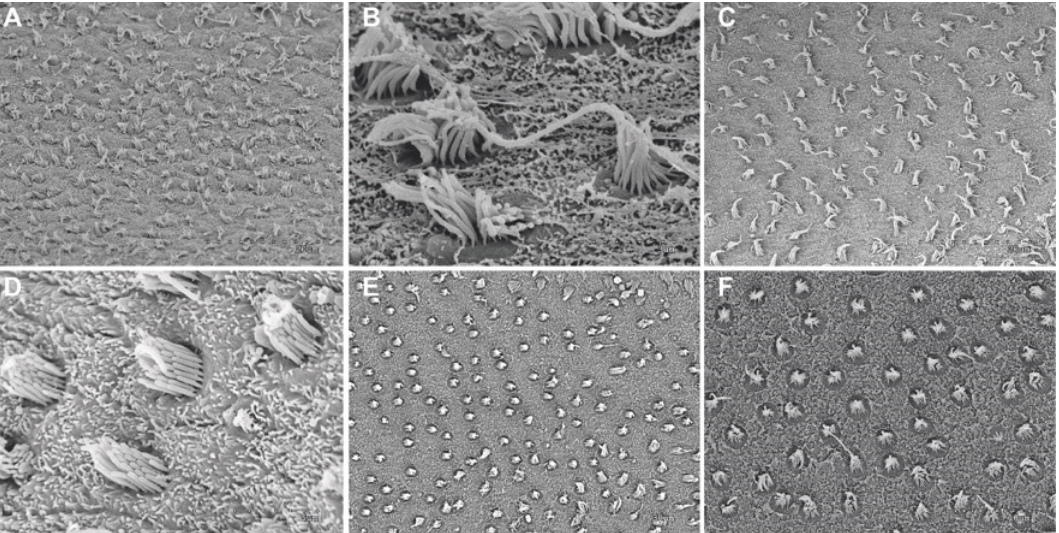
Figure 6. SEM (scanning electron microscopy). Saccule sensory epithelium. ( A , B ) Exposed animals. Control. ( C – F ) By comparison with control animals, the images of the saccule epithelium show healthy sensory hair cells in all cases of exposed animals (1 week ( C ), 2 weeks ( D ), 3 weeks ( E ) and 4 weeks ( F ) of sound exposure). Scale bar: E = 30 µ m. ( A , C ) = 20 µ m. ( F ) = 10 µ m. ( D ) = 5 µ m. ( B ) = 3 µ